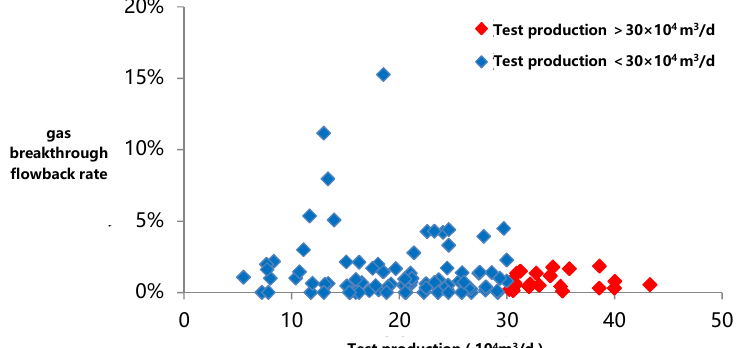
Figure 10. Schematic diagram of relationship between gas breakthrough flowback rate and test production of shale gas wells.